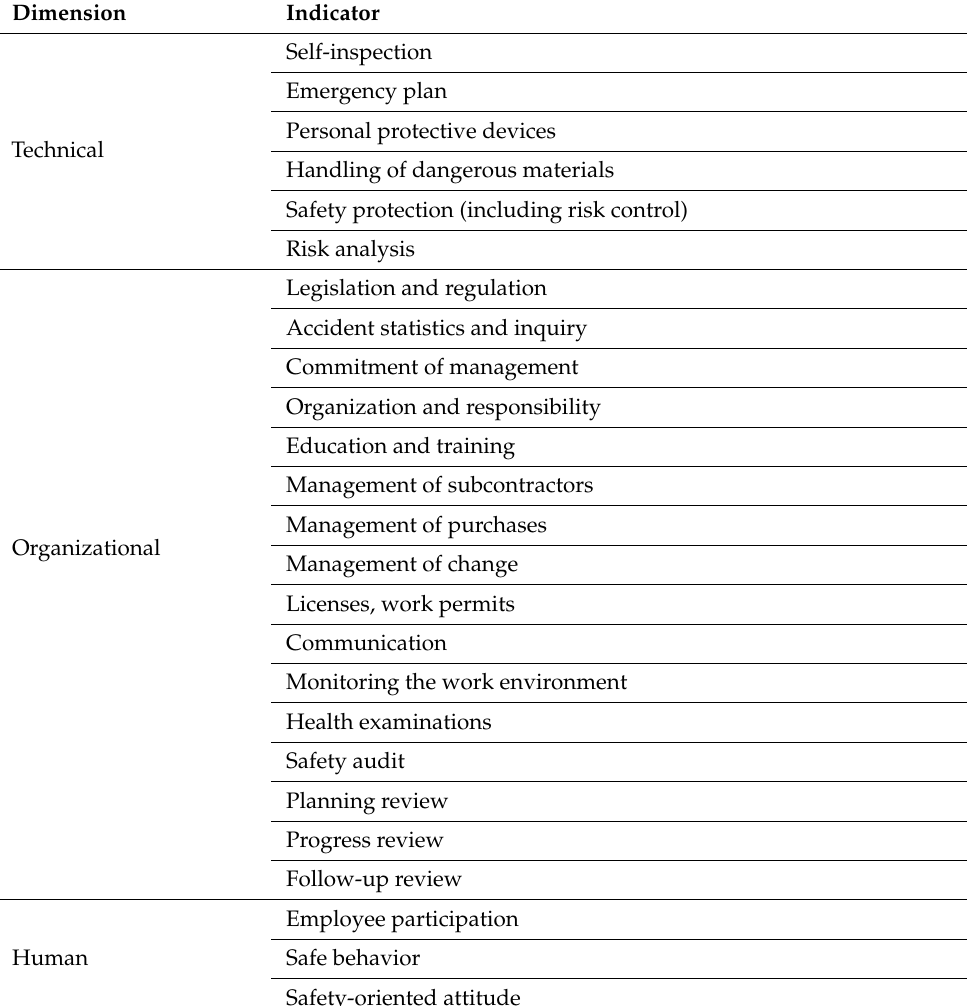
Table 8. Indicators included in the TSP tool